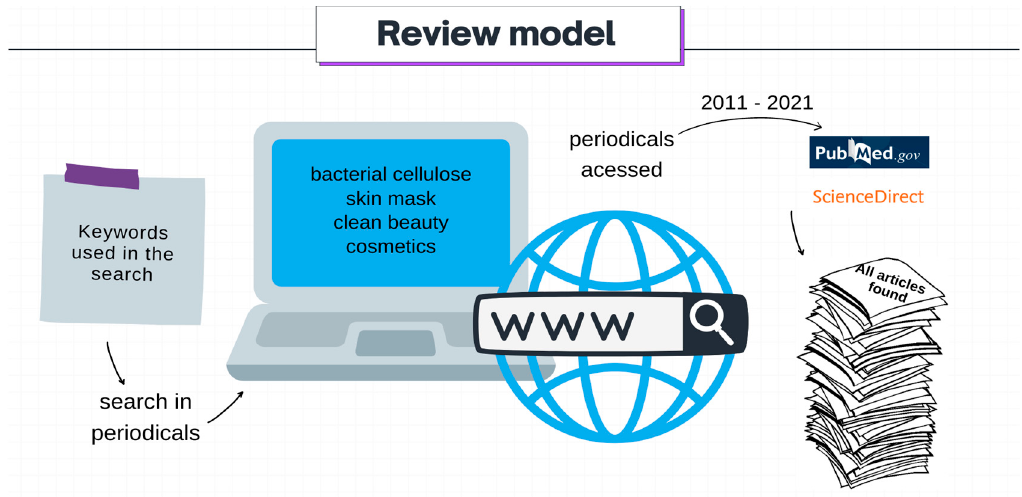
Figure 3. Diagram used to define and limit the search for studies based on key words.